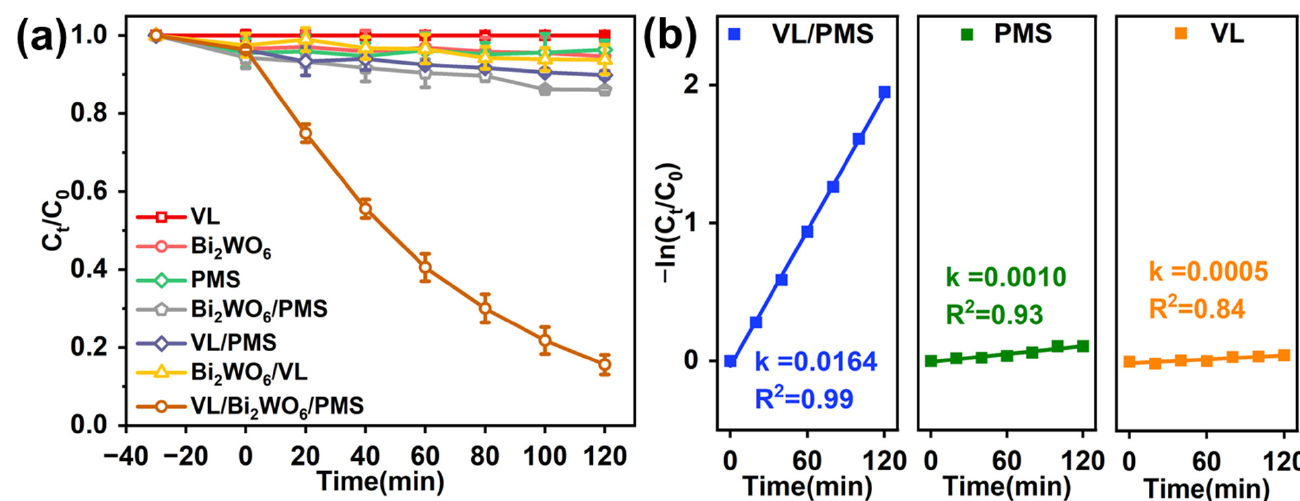
Figure 2. CBZ degradation performance under different comparative oxidation processes ( a ) and the rate constants of different cases with Bi 2 WO 6 ( b ). Experimental conditions: LI = 200 mW cm − 2 , Bi 2 WO 6 dosage = 1.0 g L − 1 , [PMS] 0 = 0.50 g L − 1 , [CBZ] = 10 mg L − 1 , pH = 7.0, and T = 25 °C.